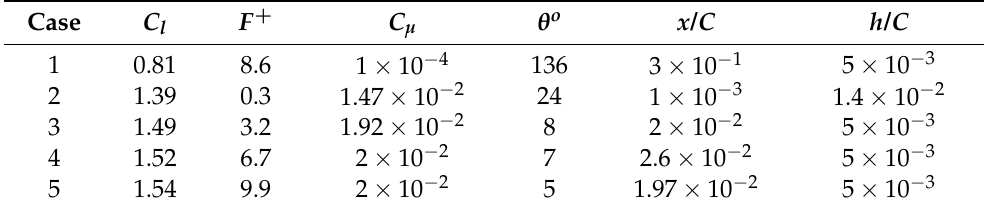
Table 5. Values of the lift coefficient and design variables of the five labeled cases.